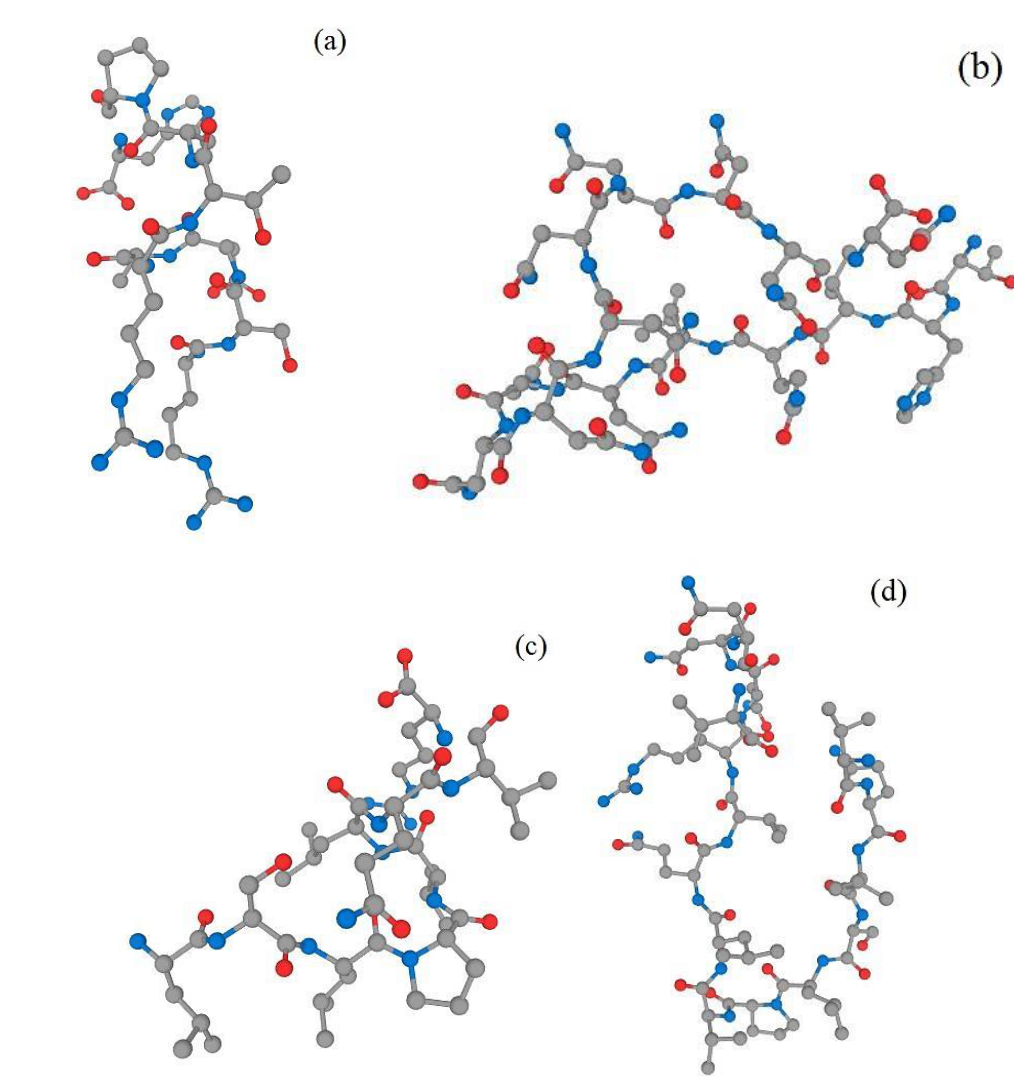
Figure 3. (a-d) 3D structure generation of the selected epitopes. (a) Selected T-cell MHC Class-I epitope for ORF1ab leader protein MT326102. (b) Selected T-cell MHC Class-II epitope for ORF1ab leader protein MT326102. (c) Selected T-cell MHC Class-I epitope for ORF1ab leader protein MT326175. (d) Selected T-cell MHC Class-II epitope for ORF1ab leader protein